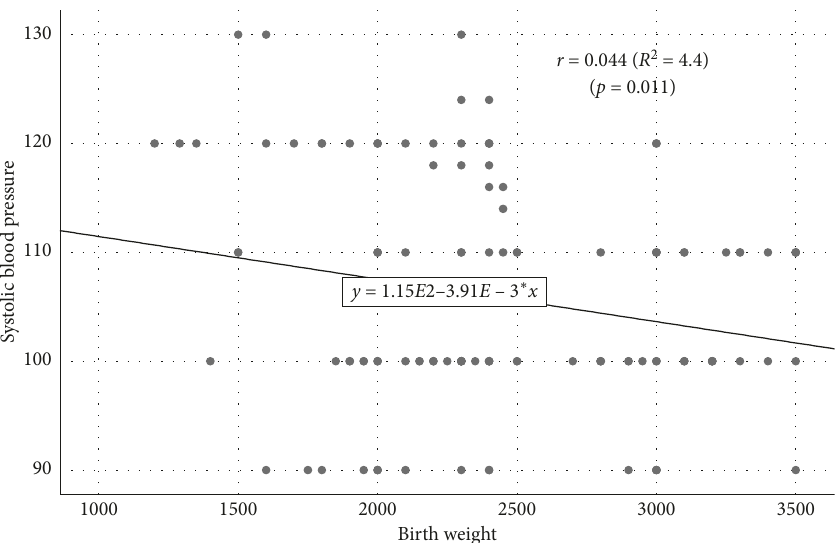
Figure 5: Scatterplot diagram for the association between birth weight and systolic blood